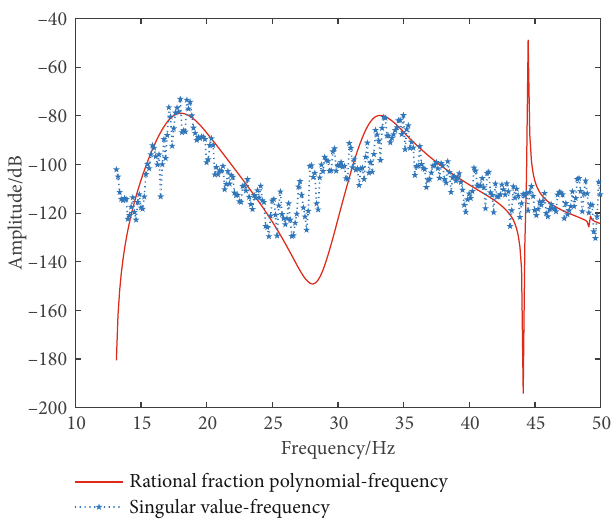
Figure 25: System identi fi cation result including the 17.9Hz and